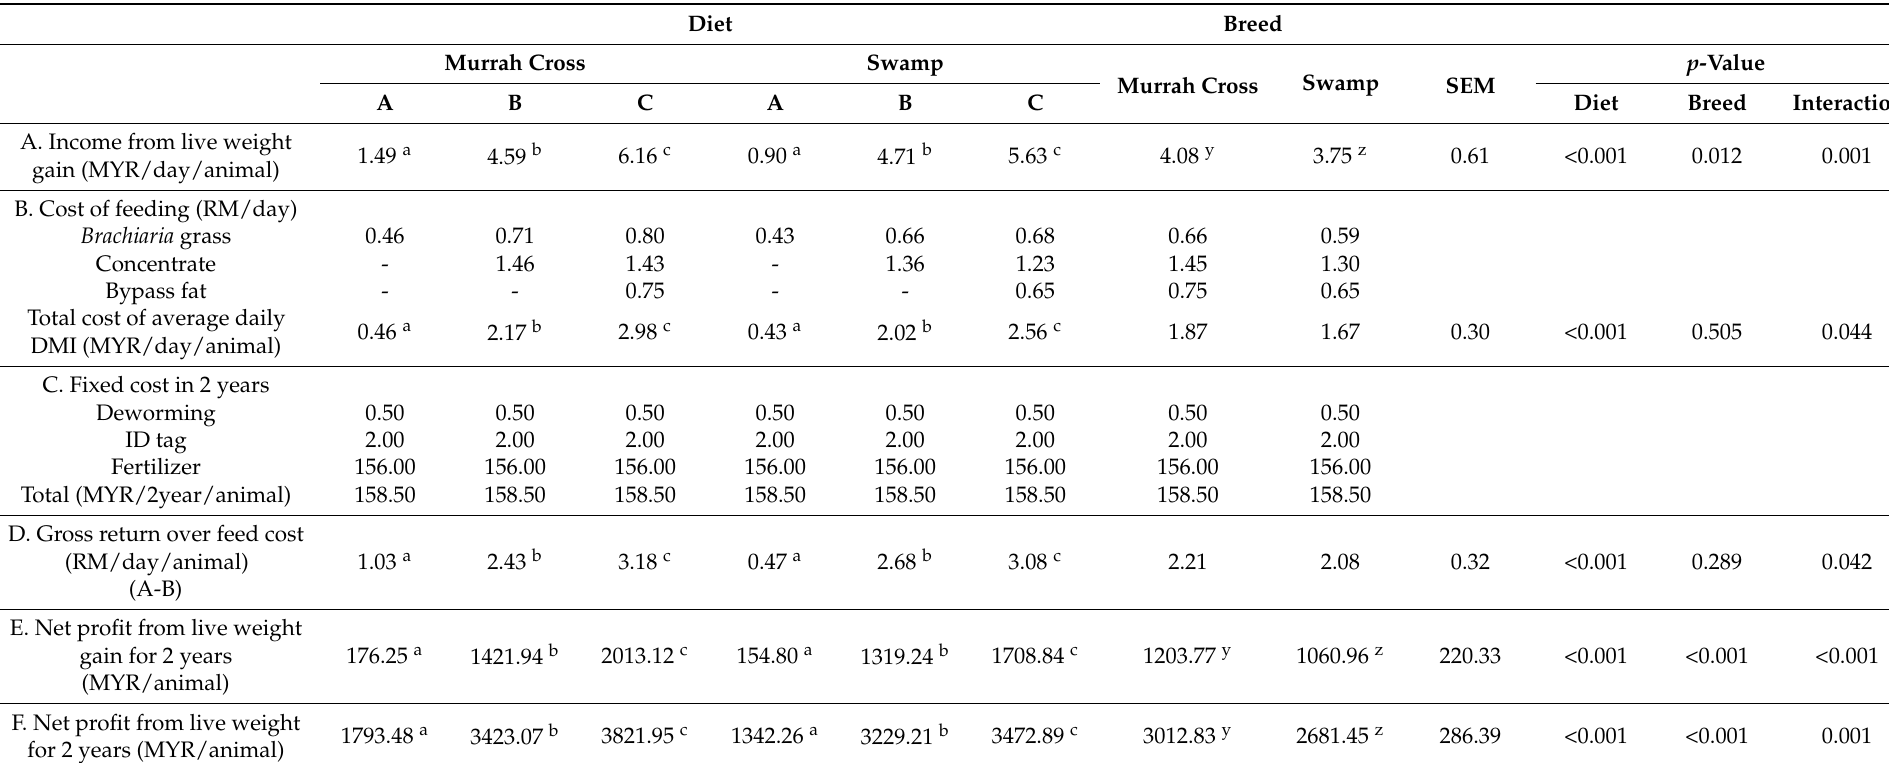
Table 6. Cost analysis (RM) of buffaloes fed with different supplemented diet. Diet